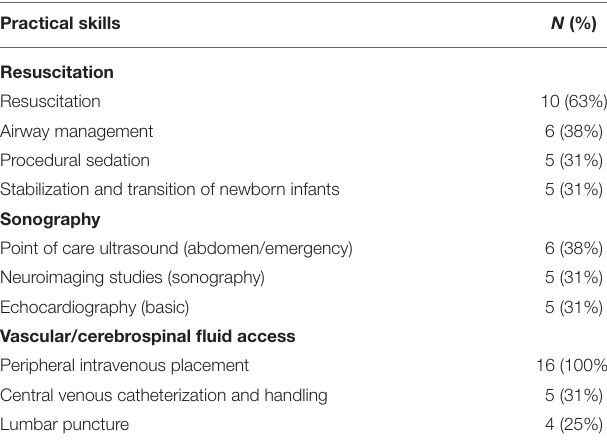
TABLE 3 | Extracted key knowledge themes from the importance performance analysis (IPA) high-importance and low-performance panel ( n = 23) ranked by their importance ( = number of occurrence) with nephrology themes in